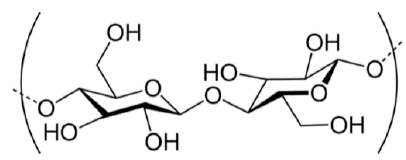
Figure 7. Chemical structure of cellulose unit.